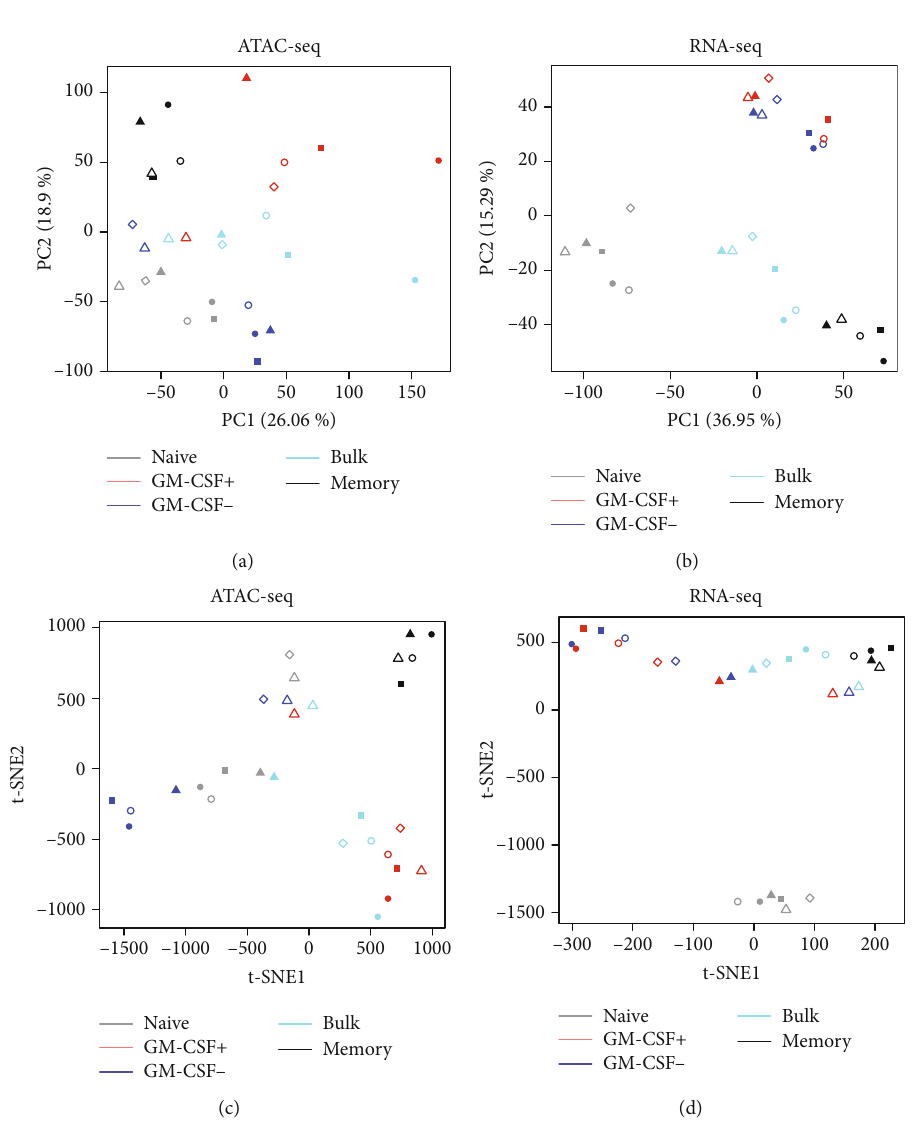
Figure 2: Explorative analysis of ATAC-seq and RNA-seq samples. (a) Principal component analysis (PCA) was carried out on CQN- ð RPKM + 1 Þ centered by mean subtraction for each feature (genomic region). PC1 and PC2 are normalized ATAC-seq data given as log 2 shown, along with the % variation explained. Symbol colors indicate the given cell populations and symbol shapes and fi llings represent individual donors ( n = 5 – 6 donors) as in Figure1(c). Data from technical replicates were pooled before analysis. (b) PCA for RNA-seq ð FPKM + 1 Þ centered by mean subtraction for each feature (gene). Labels as in (a). (c, d) t-SNE dimensionality reduction data given as log 2 visualization of (c) ATAC-seq and (d) RNA-seq data, processed and labeled as in (a) and (b),